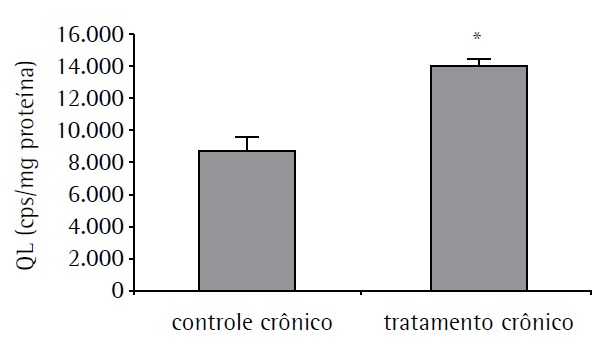
Média dos níveis de peroxidação lipídica nos pulmões de ratos submetidos
a administração crônica de metilprednisolona oral (grupo de tratamento
crônico) ou não (grupo de controle crônico). QL: quimioluminescência; e cps:
contagens por segundo. *p < 0,05, teste t de Student